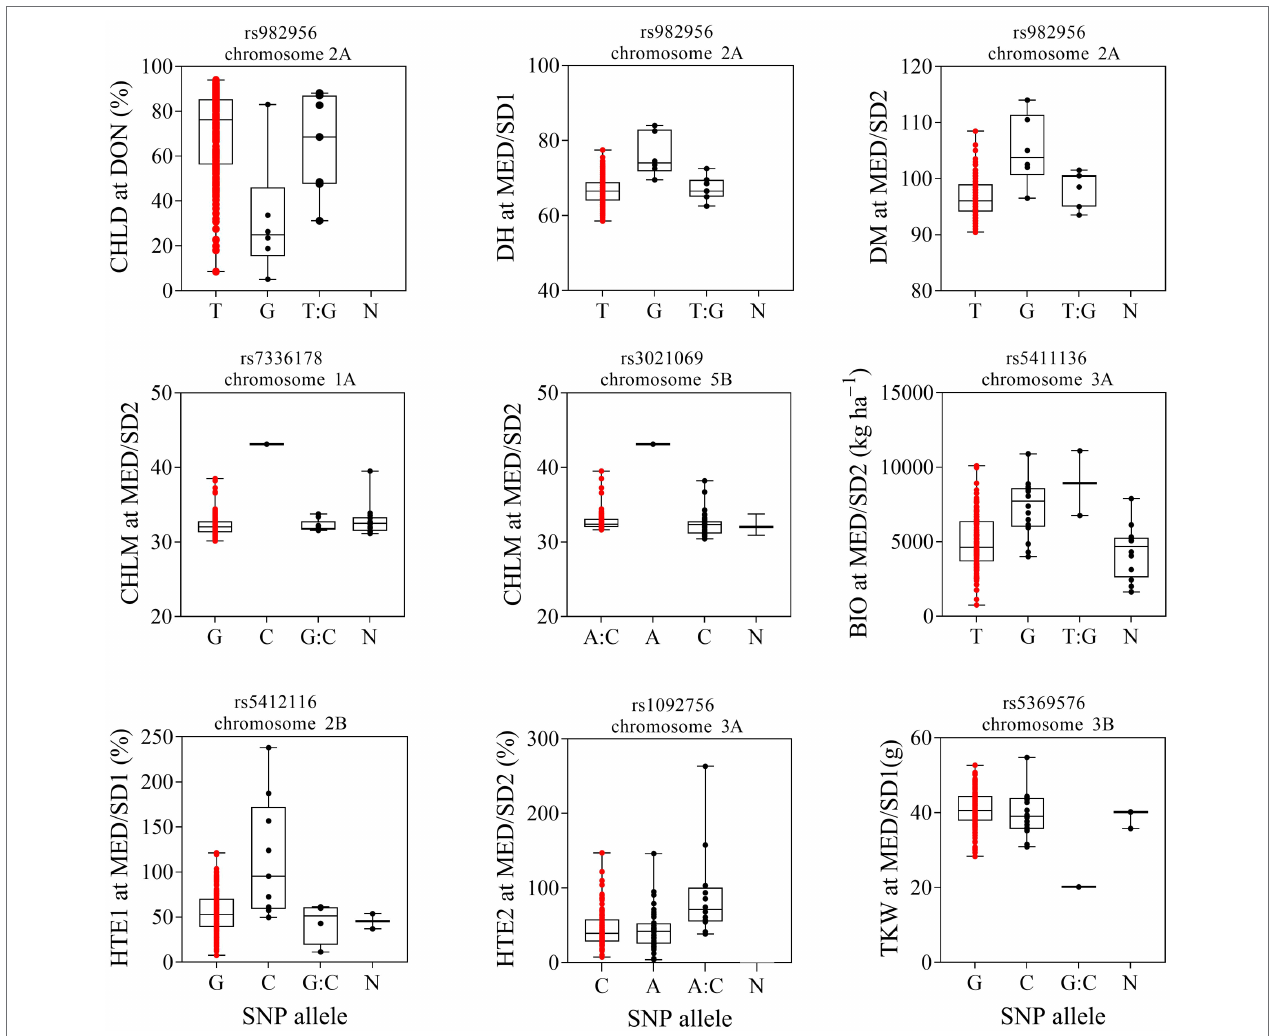
FIGURE 7 | Effect of selected marker-trait associations for different traits evaluated at Dongola (DON), Wad Medani first sowing date (MED/SD1) or Wad Medani second sowing date (MED/SD2). BIO, biomass; CHLD, chlorophyll degradation; CHLM, chlorophyll at maturity; DH, days to heading; DM, days to maturity; HTE1, heat tolerance efficiency evaluated in MED/SD1; HTE2, heat tolerance efficiency evaluated in MED/SD2; TKW, thousand kernel weight. Boxes show median and interquartile range and whiskers show the range. Significant marker and chromosome identified for each trait are displayed on the top box. Red dots indicate genotypes with ‘Miki 3’ allele. A, adenine; C, cytosine; T, thymine; G, guanine; N,